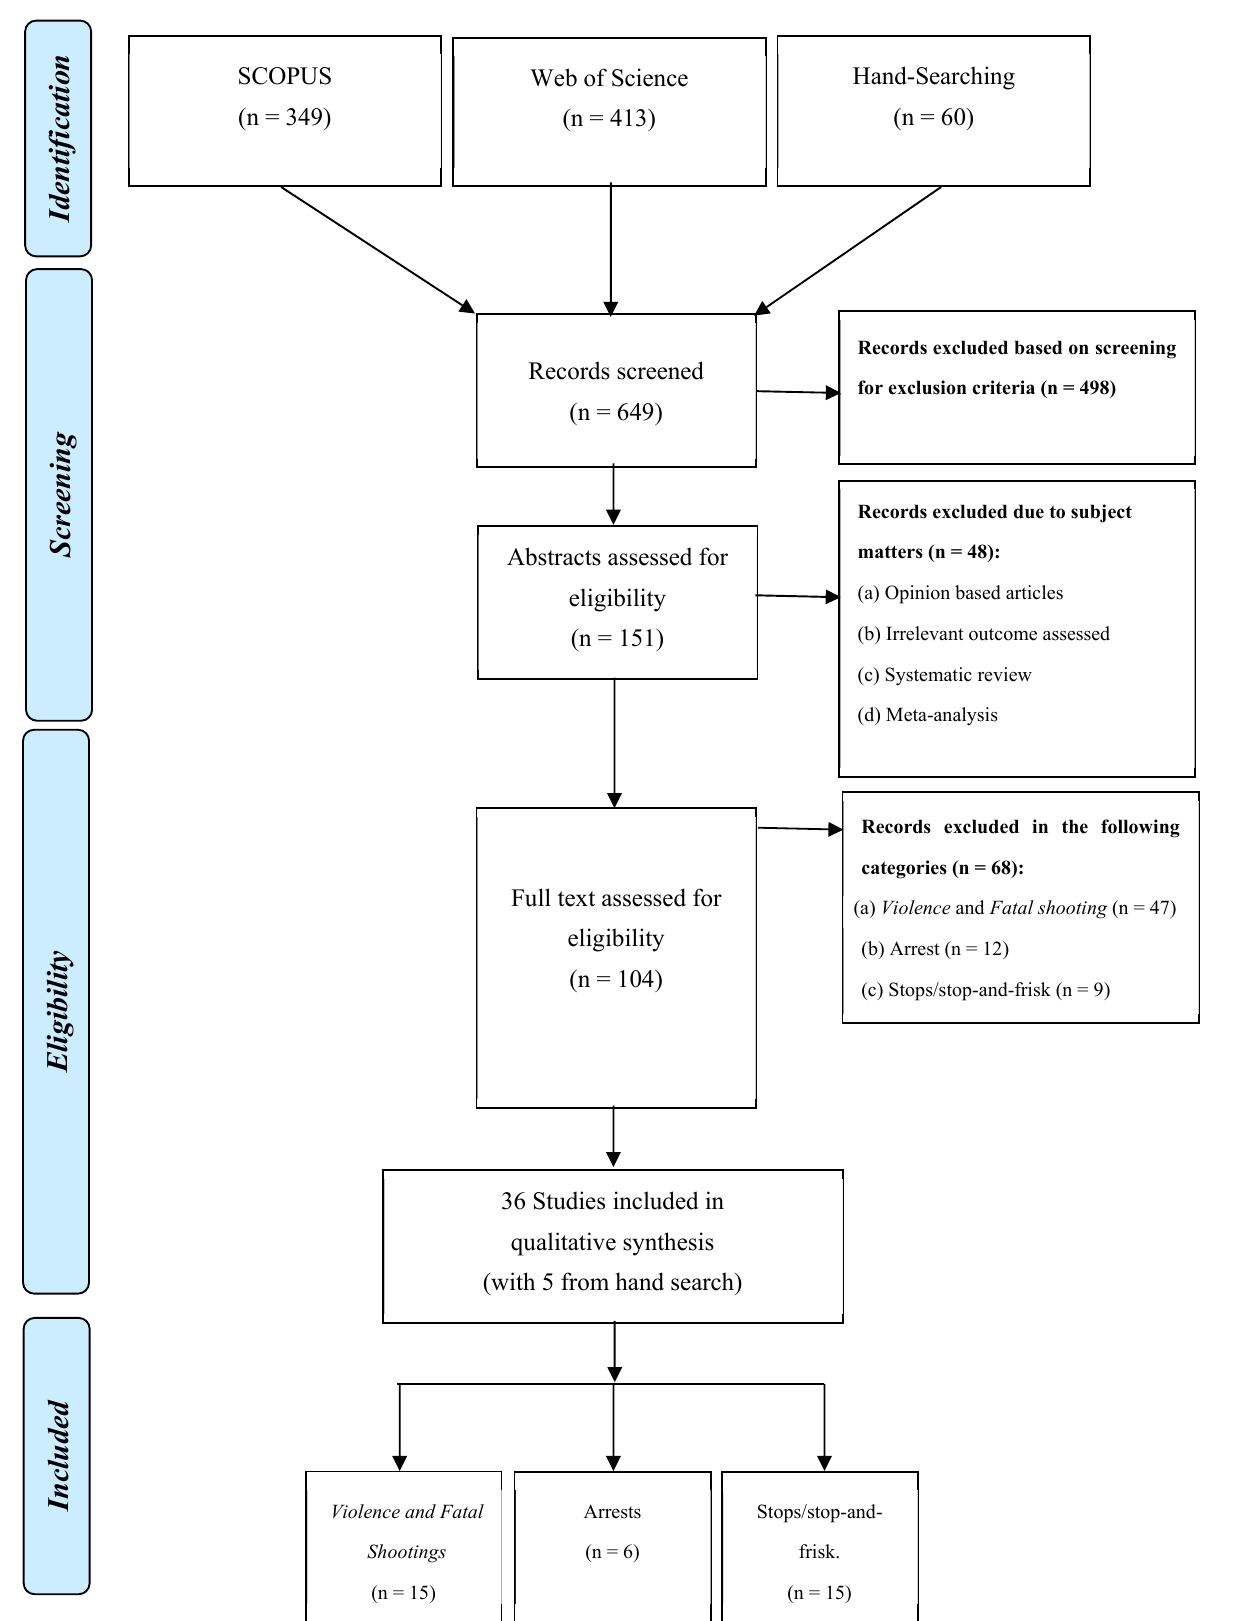
Figure 1. Distribution of articles used for the qualitative analysis.